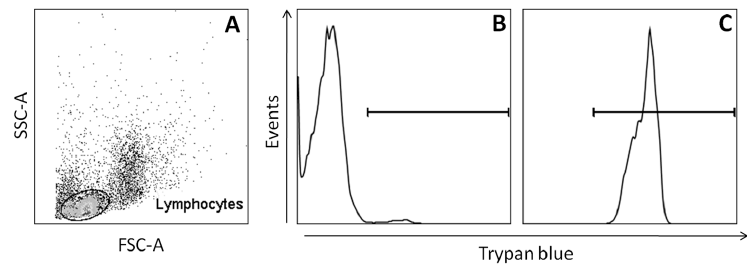
Figure 5. Computational strategy used to evaluate the percentage of dead cells by flow cytometry using trypan blue. Lymphocytes gating ( A ); selection of lymphocytes-trypan blue + in a culture with low percentage of dead cells ( B ); and high percentage of dead cells ( C ).